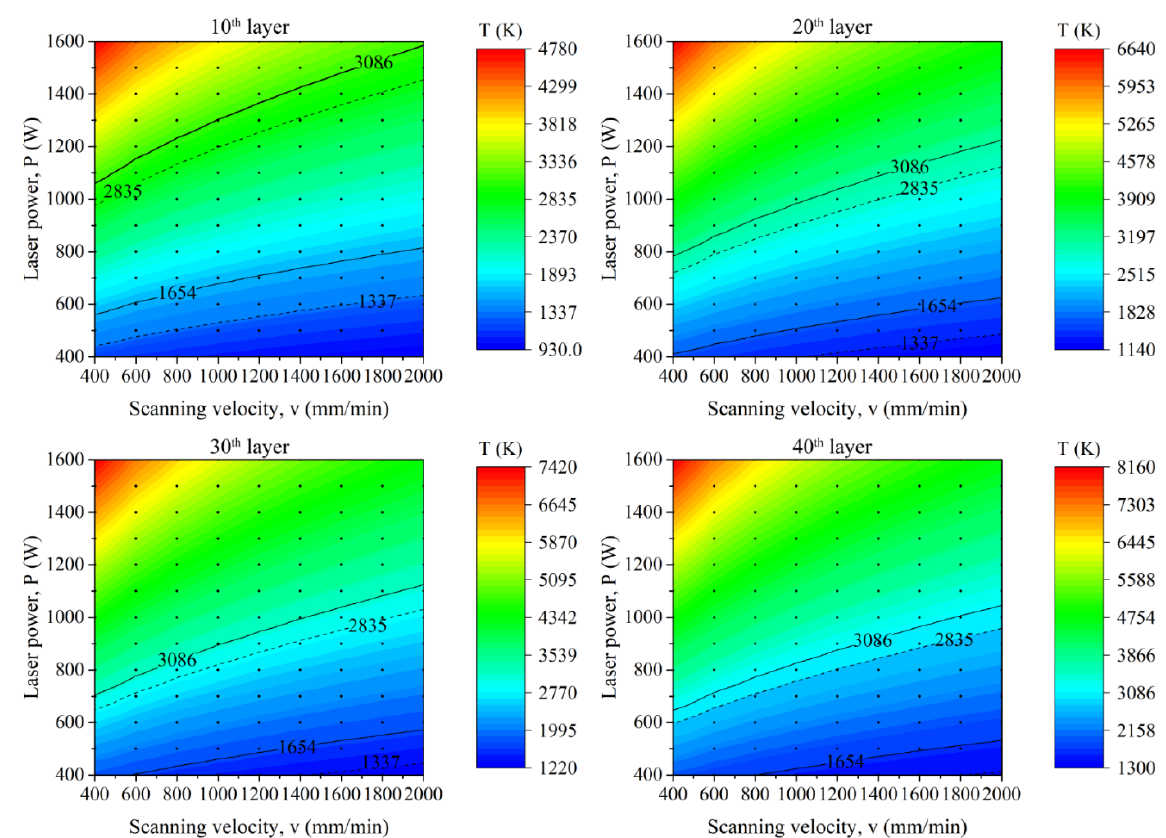
Figure 9. The peak temperature of different parameters for the 10th to 40th layers.